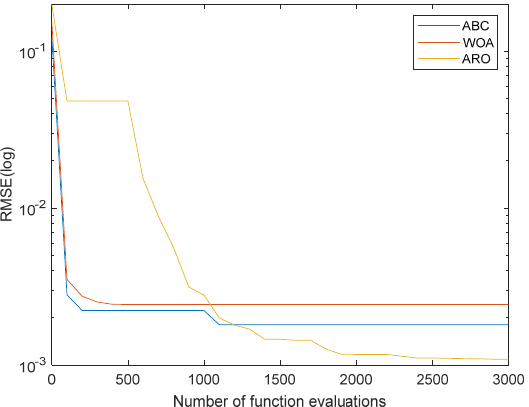
Figure 9. Convergence curves obtained by various algorithms for DDM.